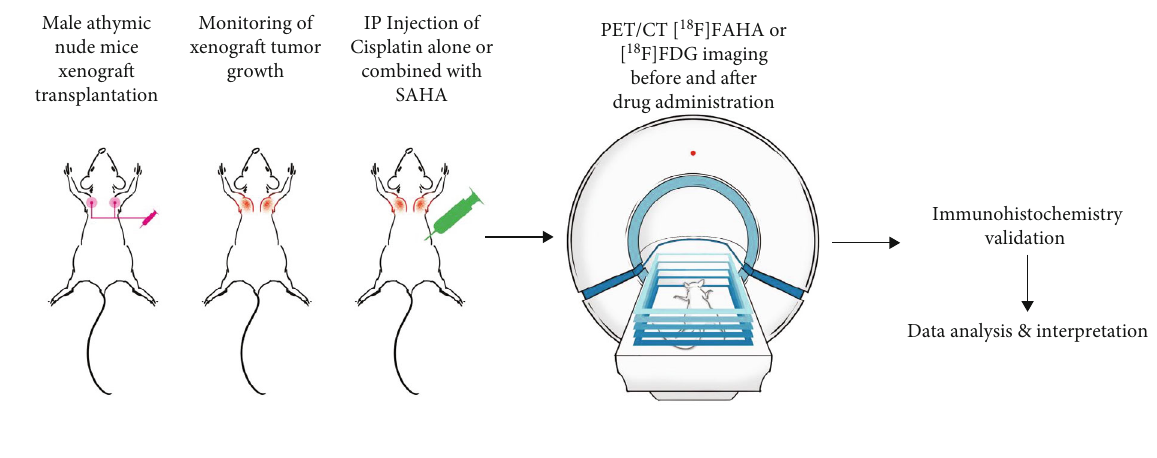
Figure 1: Schematic representation of the study protocol. Animals bearing tumor xenografts were divided to three groups and received intraperitoneal injections of 2 mg/kg cisplatin (Group A), 4 mg/kg cisplatin (Group B), or 4mg/kg cisplatin with 300 mg/kg SAHA (Group C) (see Materials and Methods for details). PET/CT imaging was performed before and after drug administration. The tumors were excised for IHC after PET/CT